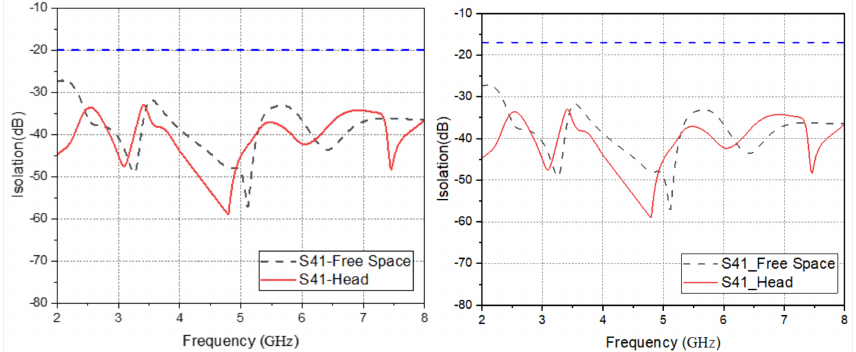
Figure 32. The free space of the simulated Ant. 1 and Ant. 4 and the isolation degree worn on the